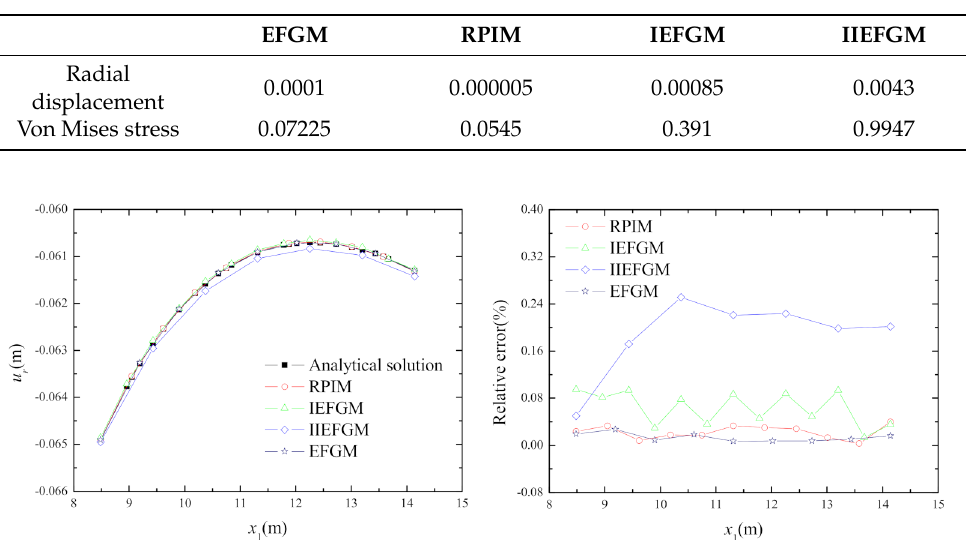
Table 5. The variances of the relative errors.